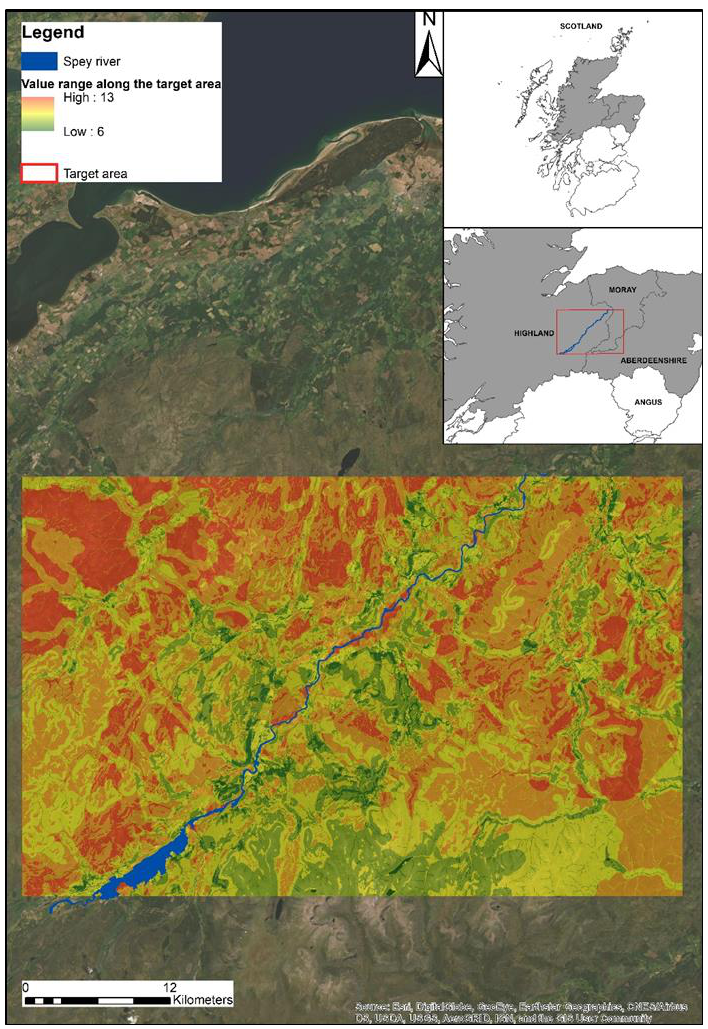
Figure 6. The value range map depicting the areas that fulfil more suitability criteria .